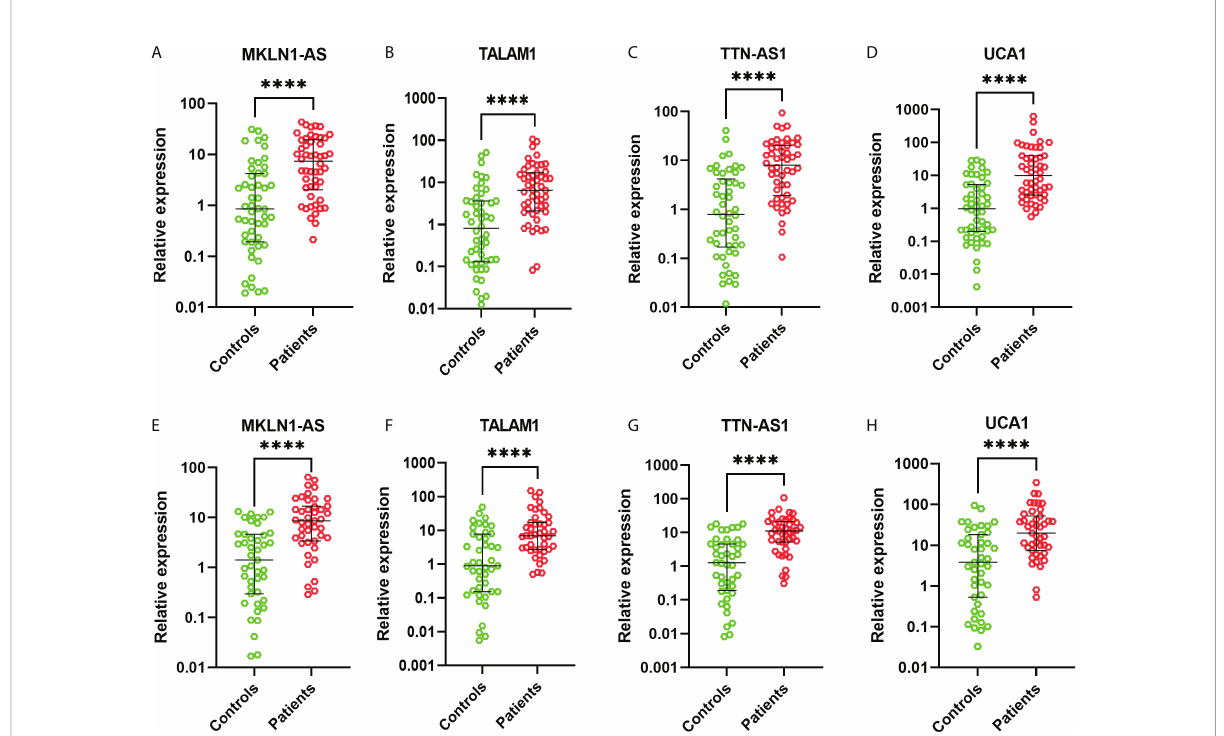
FIGURE 2 Relative expressions of lncRNAs in the training and validation cohorts. (A) MKLN1 in the training cohort (B) TALAM1 in the training cohort (C) TTN-AS1 in the training cohort (D) UCA1 in the training cohort (E) MKLN1 in the validation cohort (F) TALAM1 in the validation cohort (G) TTN- AS1 in the validation cohort (H) UCA1 in the validation